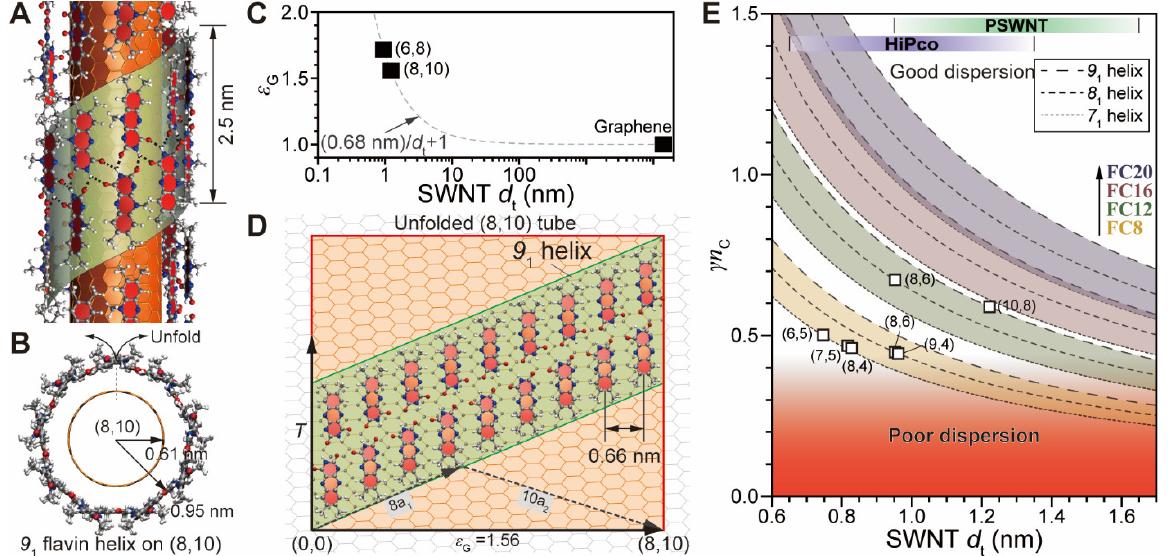
Figure 6. Calculation of the l S per carbon in the SWNT using the geometry of a 9 1 flavin helix-wrapped (8,10) tube. ( A ) Side view of helical wrapping of flavin spaced with vdW distance (0.34 nm) on (8,10) tube with d t = 1.22 nm. SWNT. Note that unit length of flavin helix is 2.5 nm. ( B ) Top view of flavin wrapping on (8,10) tube. ( C ) Plot of SWNT d t vs. graphene stretch ratio ε G along C h . Note that each SWNT chirality have different ε G . ( D ) Projected view of 9 1 isoalloxazine helix on graphene sheet with ε G = 1.56 while the length of translational vector ( T ) of (8,10) tube remains unchanged. ( E ) Plot of SWNT d t vs. γn C according to flavin derivatives and helical motifs ( 7 1 , 8 1 , and 9 1 helices). d t ranges of HiPco and PSWNT are indicated. Chirality-dependent helical motifs are obtained from Ref. [29].